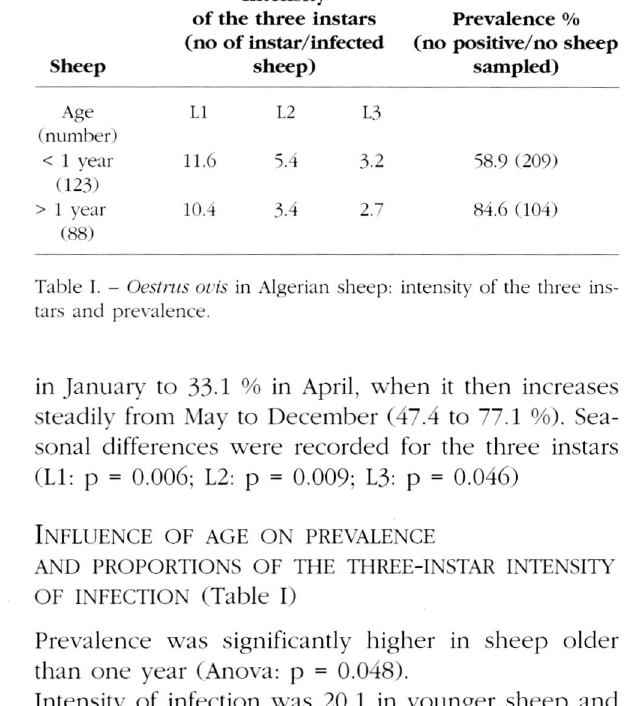
than one year (Anova; p =